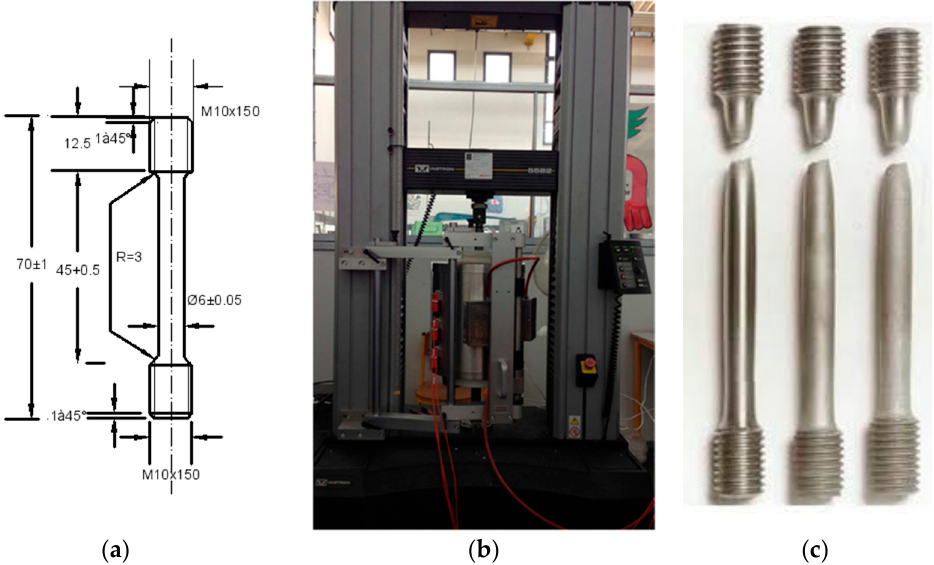
Figure 1. ( a ) Dimensions (in mm) of the coupon specimens, ( b ) UTM machine with Zwick/Roell 3-zone high temperature furnace, and ( c ) failure modes at high temperatures.